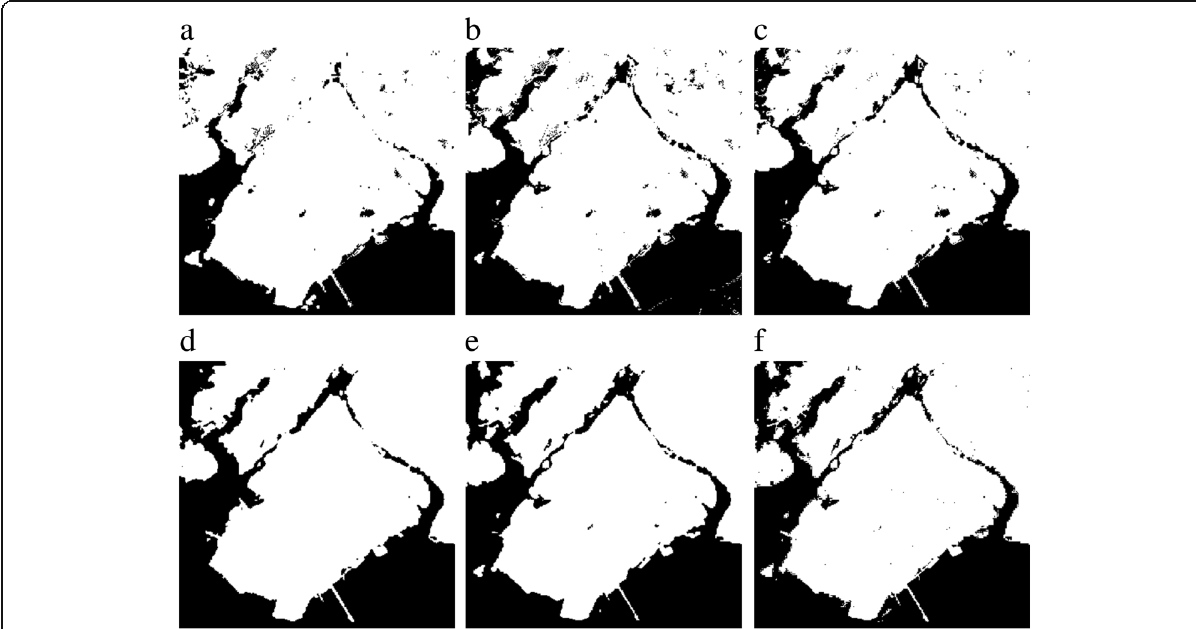
Fig. 10 Extracted water bodies (black) from the different water indexes based on optimum threshold value: ( a ) NDWI of McFeeters [13], ( b ) NDWI of Rogers and Kearney [14], ( c ) MNDWI of Xu [15], ( d ) AWEI nsh of Feyisa et al. [16], ( e ) AWEI sh of Feyisa et al. [16], and ( f ) NIR band